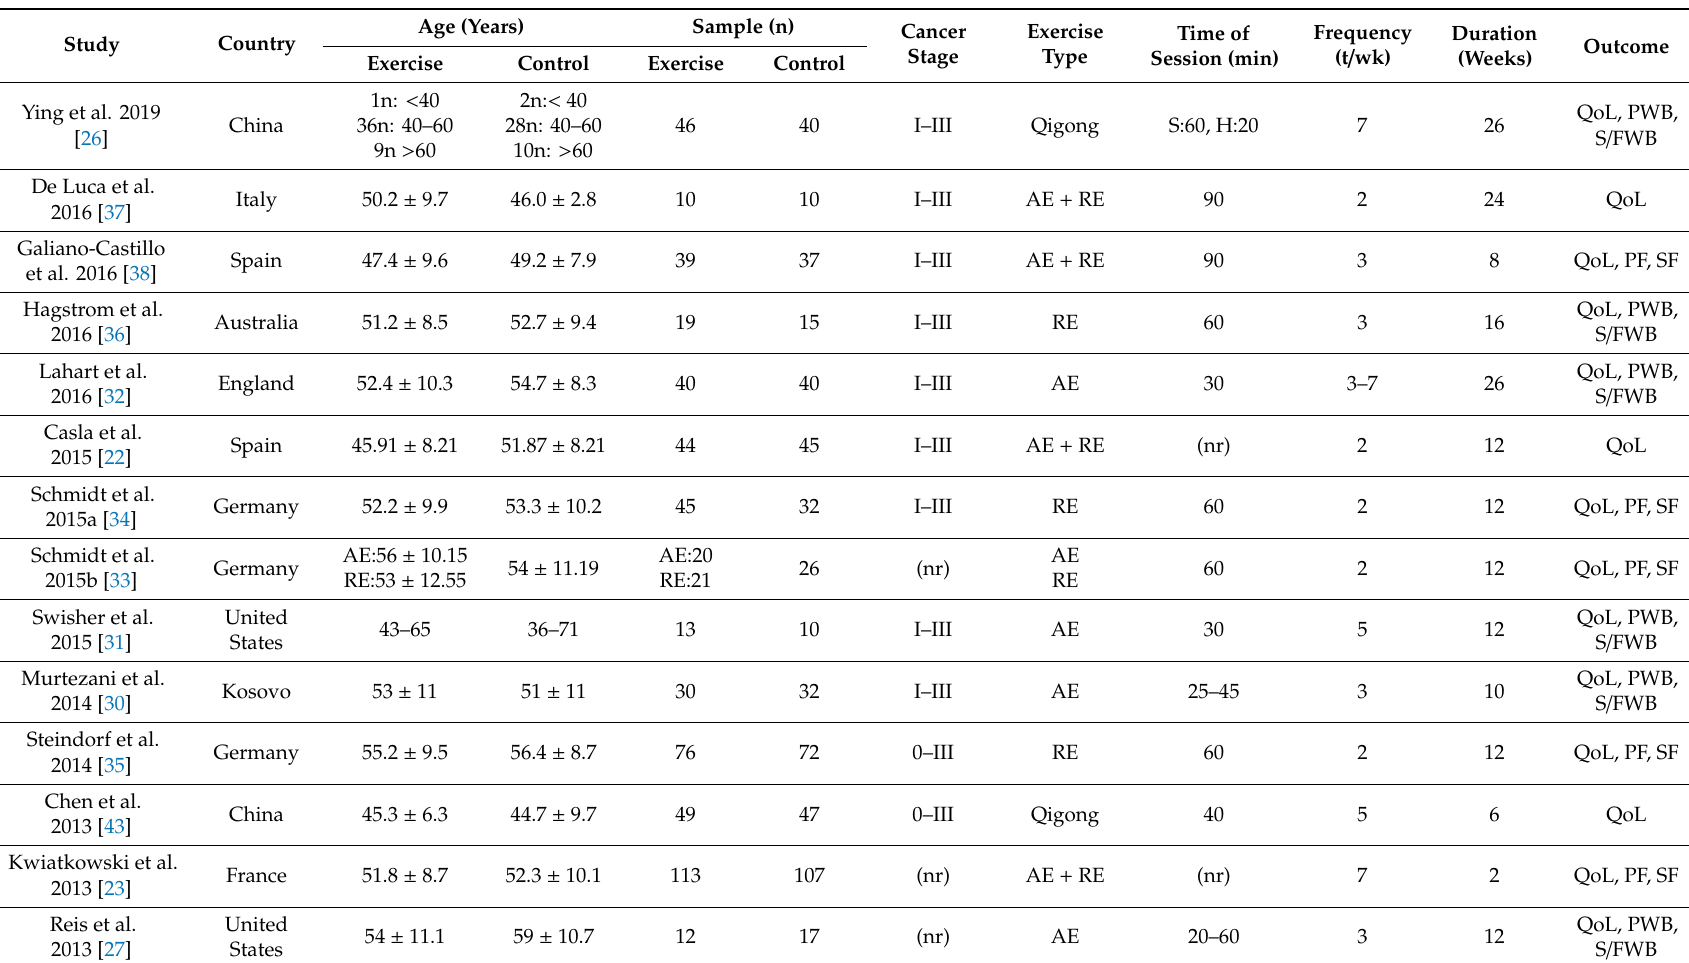
Table 1. Characteristics of the included